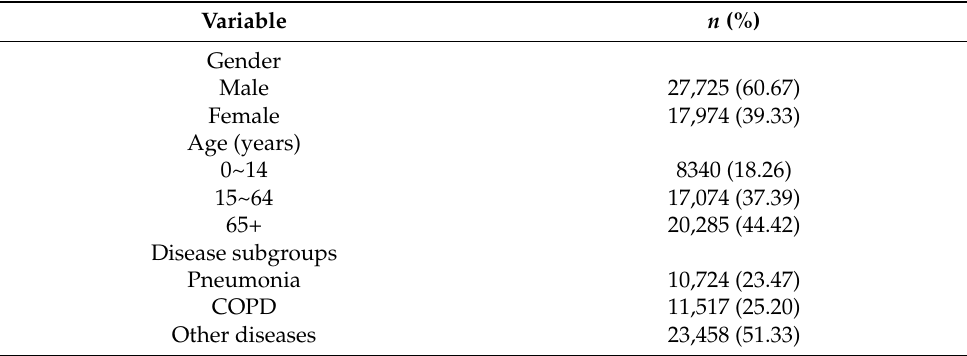
Table 2. Basic information for inpatients with respiratory diseases.